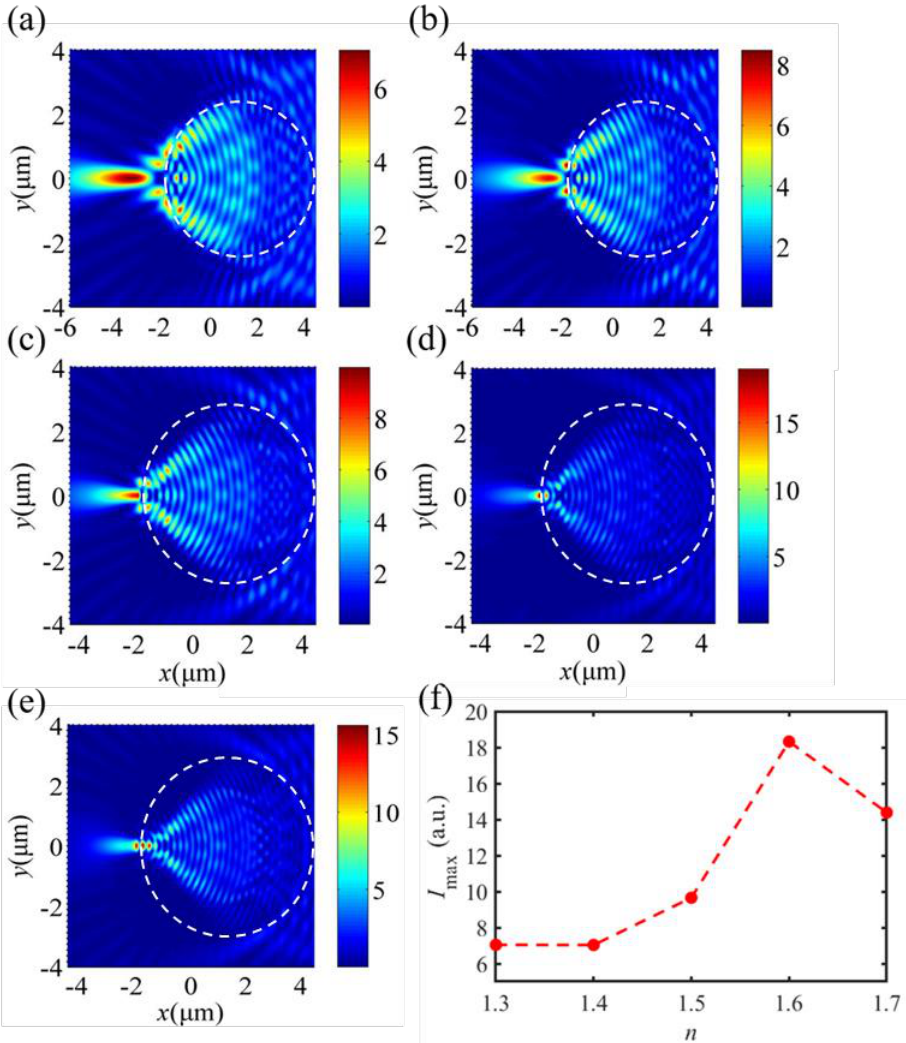
Figure 3. Optical field intensity evolution of the SPP − PNJ formed by different dielectric microdisk refractive indices: ( a ) n = 1.3, ( b ) n = 1.4, ( c ) n = 1.5, ( d ) n = 1.6, ( e ) n = 1.7, and ( f ) the maximum intensity I max evolution with different refractive indices of the dielectric microdisk.